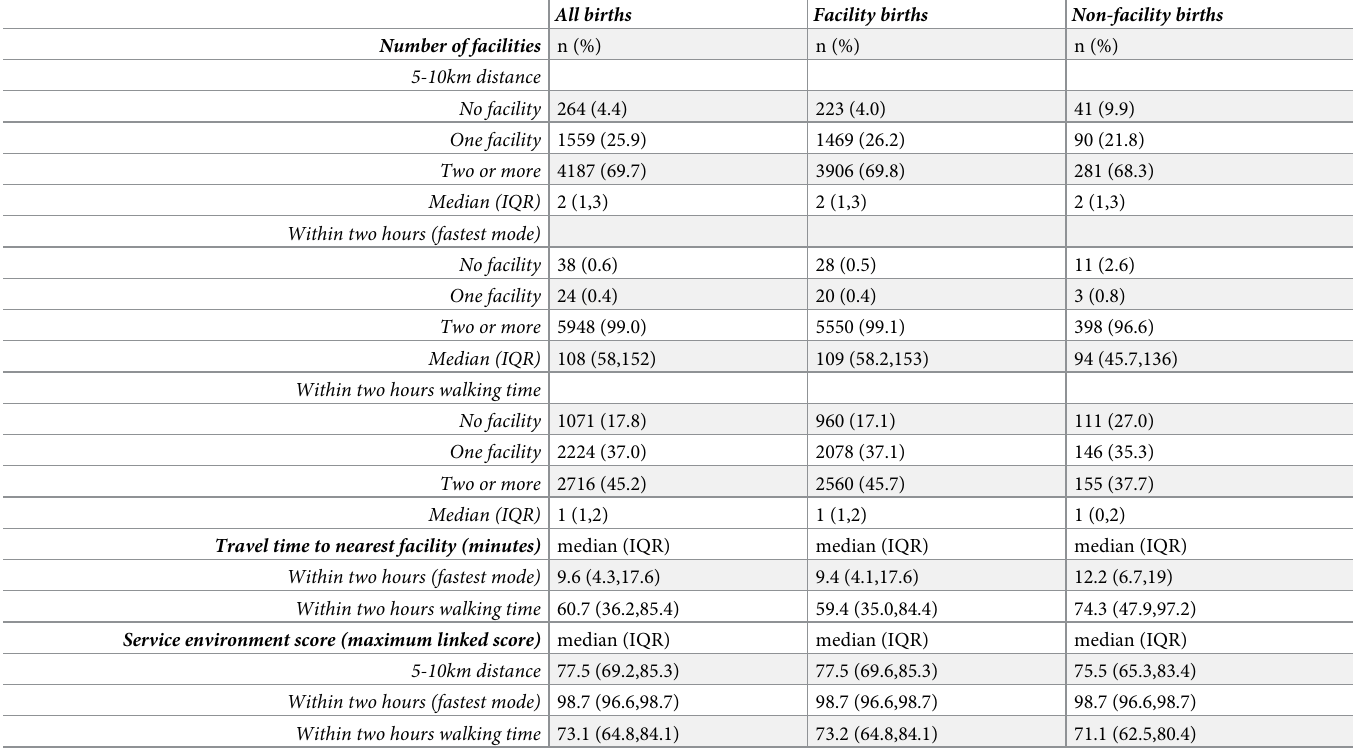
Table 2. Distance, travel time, and service environment scores for linked